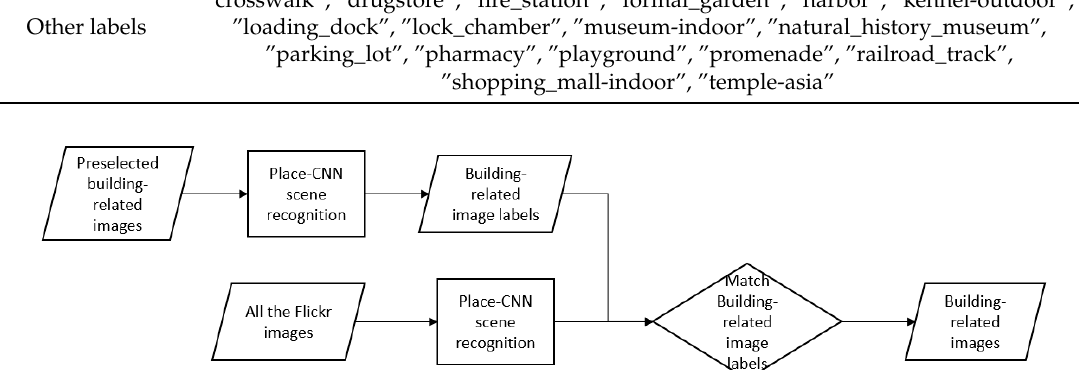
Figure 4. Detailed workflow of the data-filtering process.